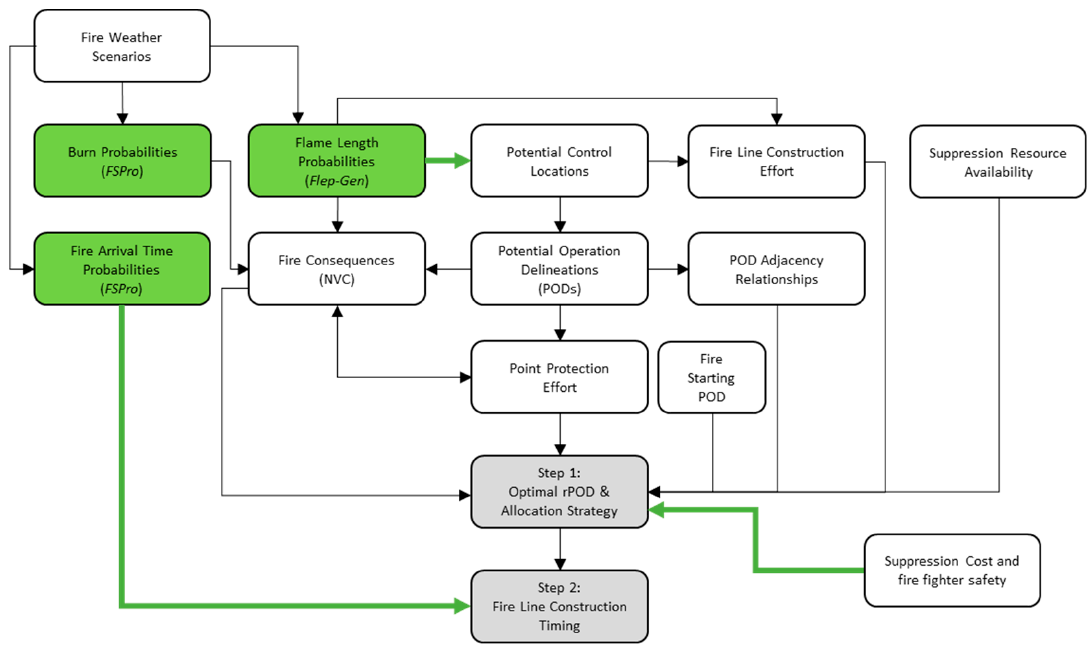
Figure 1. Model workflow. Grey boxes indicate primary model outputs, green boxes indicate probabilistic information, and green arrows indicate manager risk preferences, white boxes indicate other input data or intermediate model outputs during the